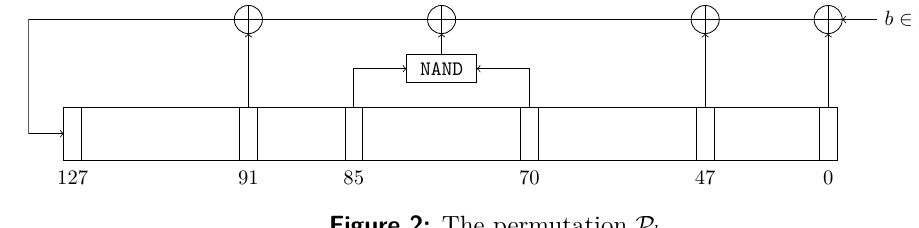
Figure 2: The permutation P b